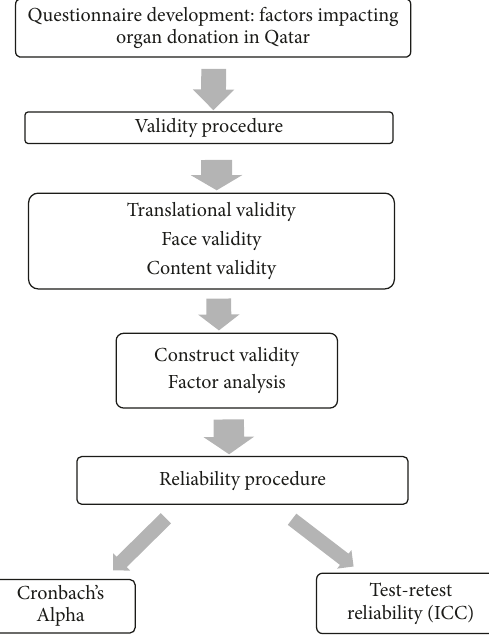
Figure 1: A flowchart depicting the process used for validating the questionnaire for understanding factors impacting organ donation in